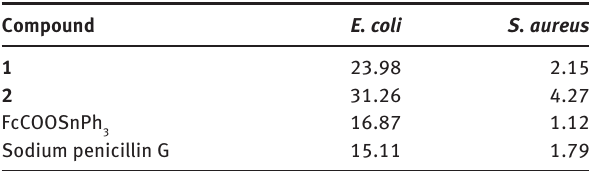
Table 2 Antibacterial activity (MIC, μ g/mL) of the compounds a .